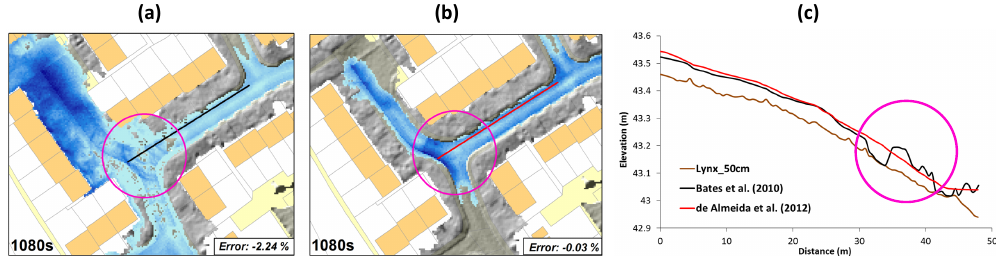
Fig. 5. (a) Simulation result at t =1080s using inertial formulation Bates et al. (2010). (b) Simulation result at t =1080s using inertial formulation de Almeida et al. (2012), (c) water surface profiles with original 50cm terrestrial LIDAR DEM